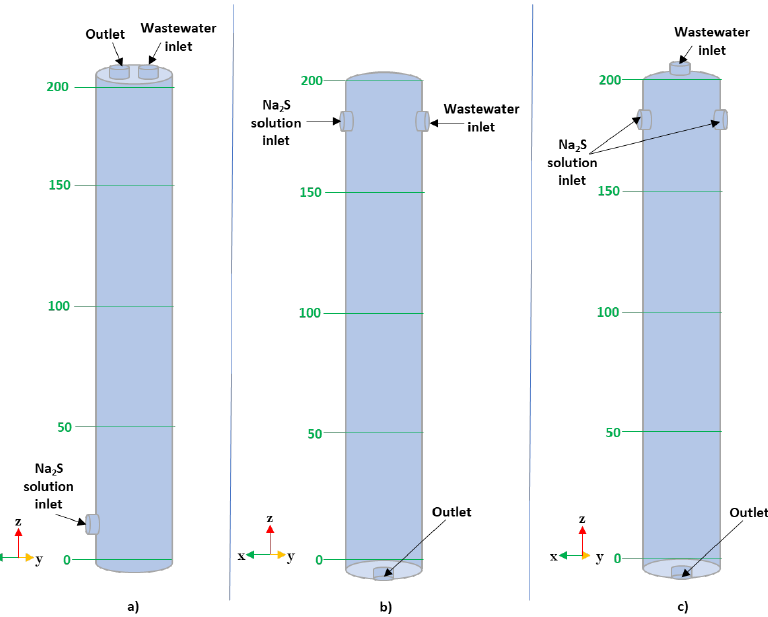
Figure 4. Geometry proposed for three CFSPR assessed by Yang and colleagues [71]. ( a ) N ◦ 1, ( b ) N ◦ 2, and ( c ) N ◦ 3. Adapted from [71].